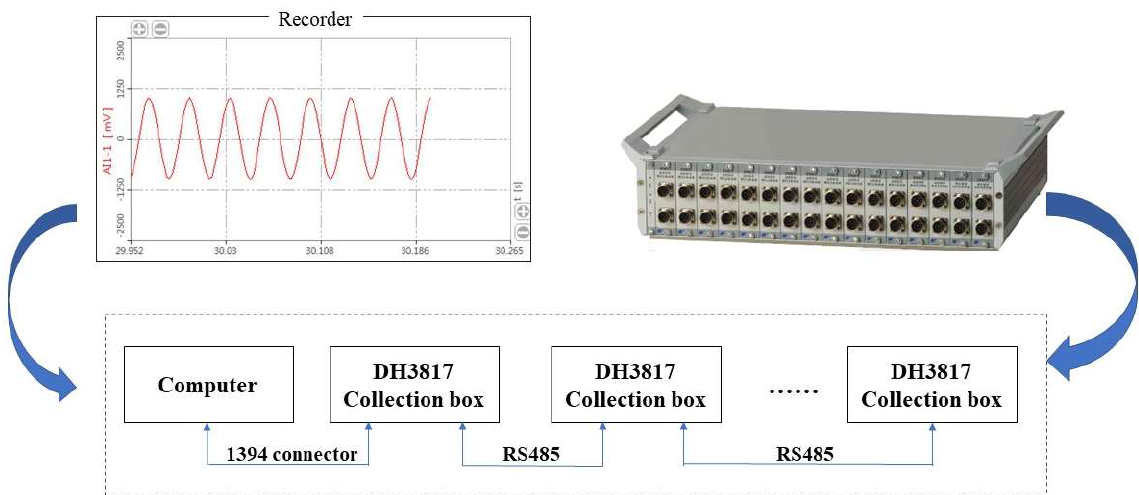
Figure 6. Working principle of DH3817.